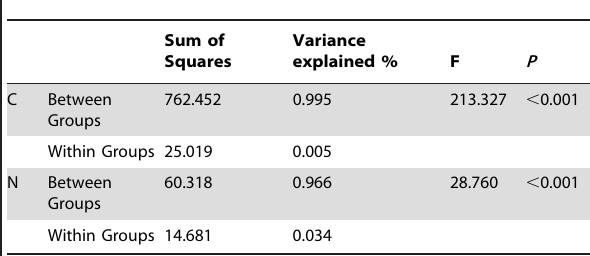
Table 5. Multivariate and univariate general linear models for differences in carbon and nitrogen stable isotope composition between the three tissues. Multivariate repeated anova Wilks’ l